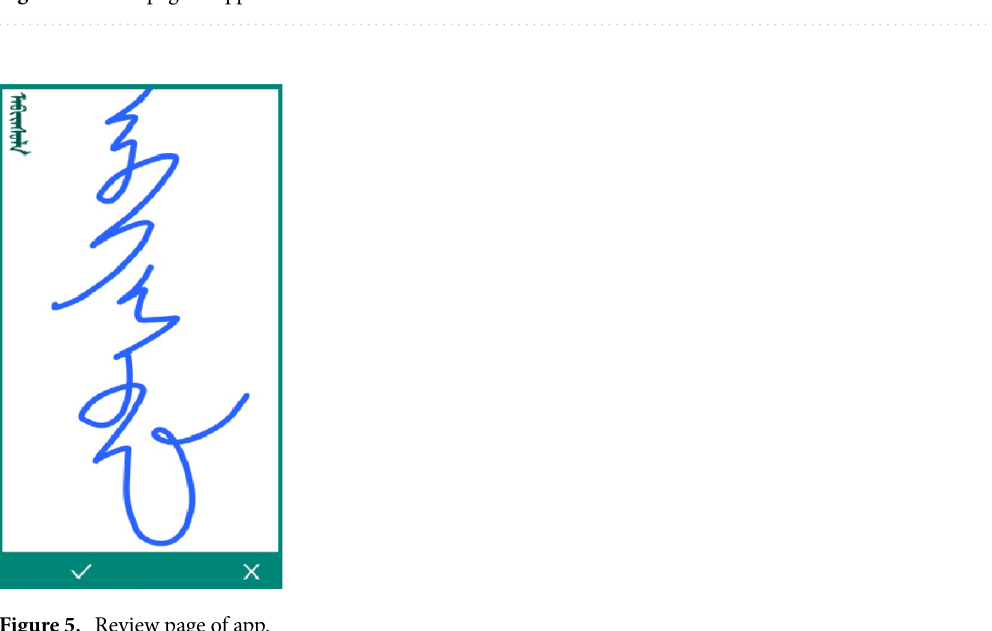
Figure 5. Review page of app.